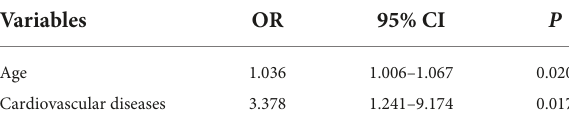
TABLE 4 Factors independently associated with mixed infections of